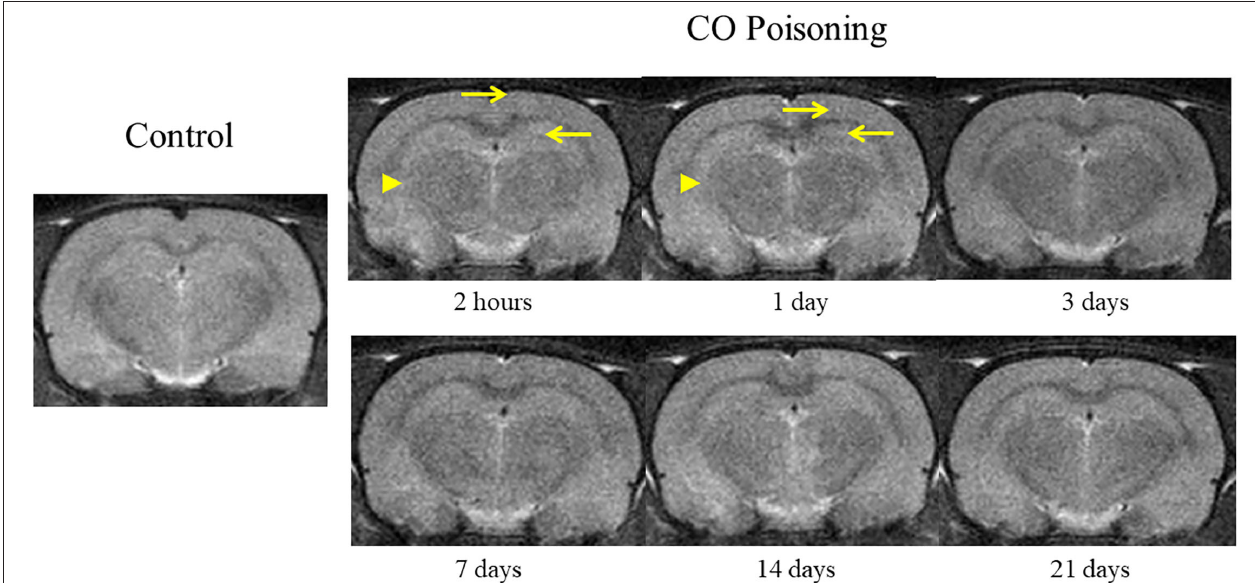
FIGURE 3 | Representative T 2 WI images at different time points before and after CO exposure.